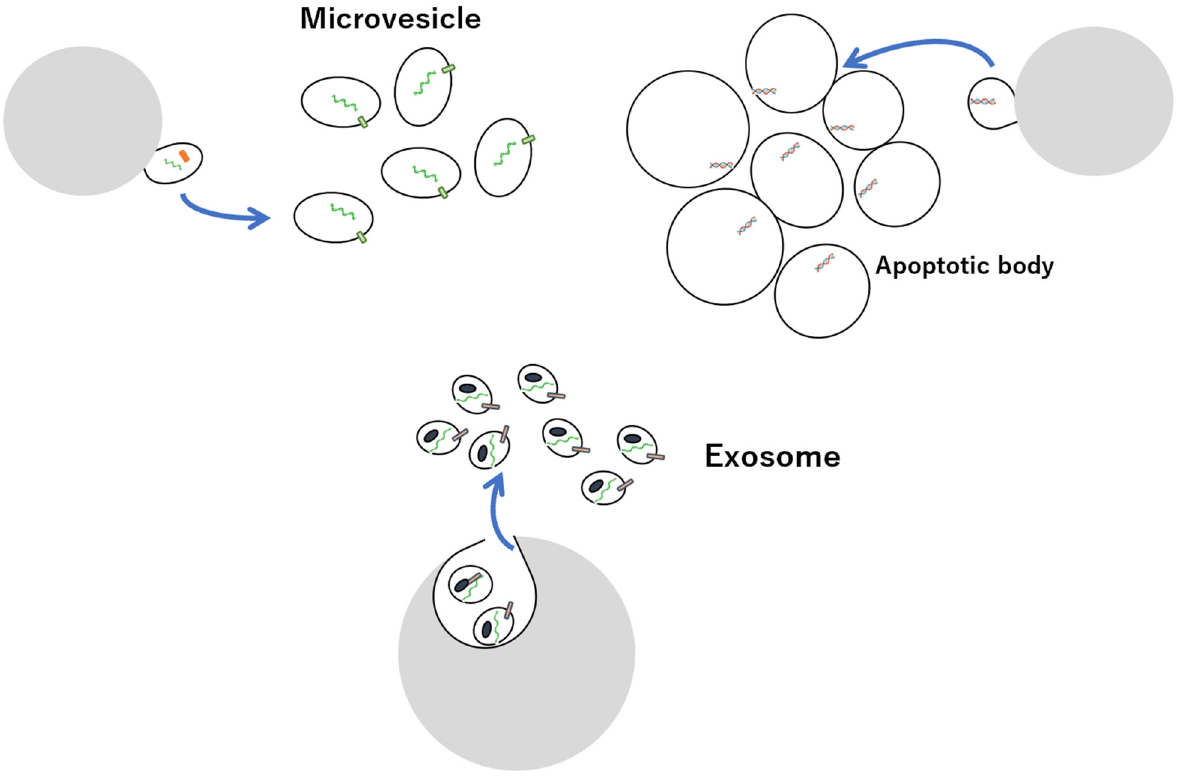
Figure 1. Overview of EVs exosomes, microvesicles, and apoptotic bodies. Conversely, MVs are vesicles with a wide range of sizes (100–1000 nm) and bud directly from the cell membrane into the outside of the cell [208,209]. Although MVs production mechanisms differ, many MVs are similar to exosomes, rendering them indistinguishable. Apoptotic bodies, micrometres in size, are particles in which apoptotic cells are displayed from the membrane and can be separated via low-speed centrifugation, hence are distinguishable from MVs and exosomes [210–213].